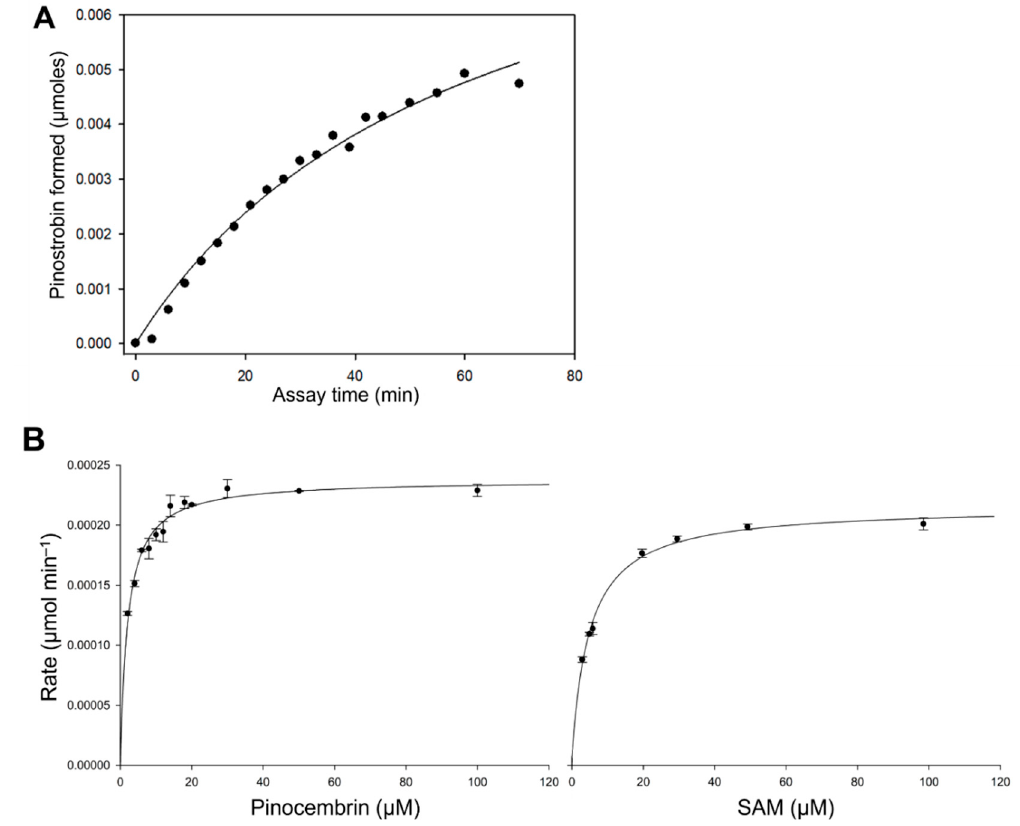
Figure 4. Kinetic characterisation of EnOMT1 methyltransferase. ( A ) Rate of formation of pinostrobin catalysed by EnOMT1 at a pinocembrin substrate concentration of 300 μ M with respect to assay time; ( B ) Michaelis–Menten curves of pinostrobin produced by EnOMT1 over a range of pinocembrin and SAM concentrations.